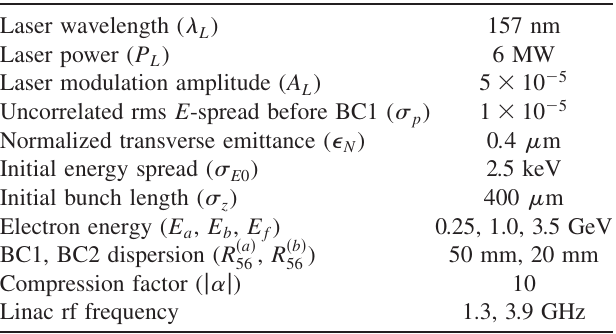
TABLE I. Parameter list for both 1D ( MATLAB ) and 3D ( ELEGANT ) simulations. We choose L -band rf frequencies because the larger diameter structures will mitigate the effect of wakefield fluctuations. We have not listed bunch charge because without wakefield effects the simulations are charge independent.